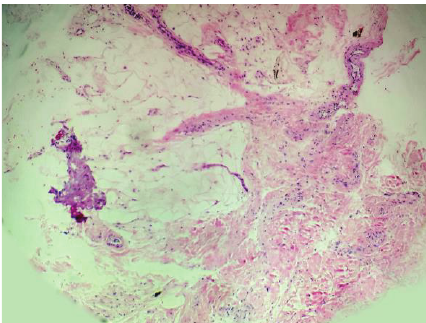
Figure 6: Histology of synovial biopsy. Section shows fibrocollage- nous and fatty tissue containing blood vessels. No inflammation